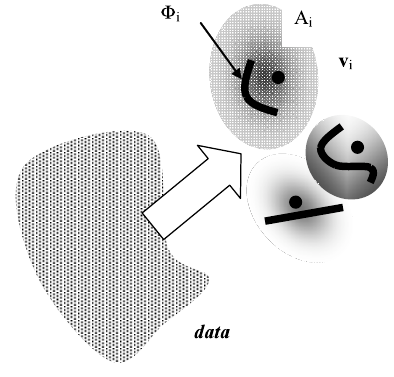
Figure 2. The framework of fuzzy modeling: data are cast in a certain perspective of information granules A i and with associated are local models Φ